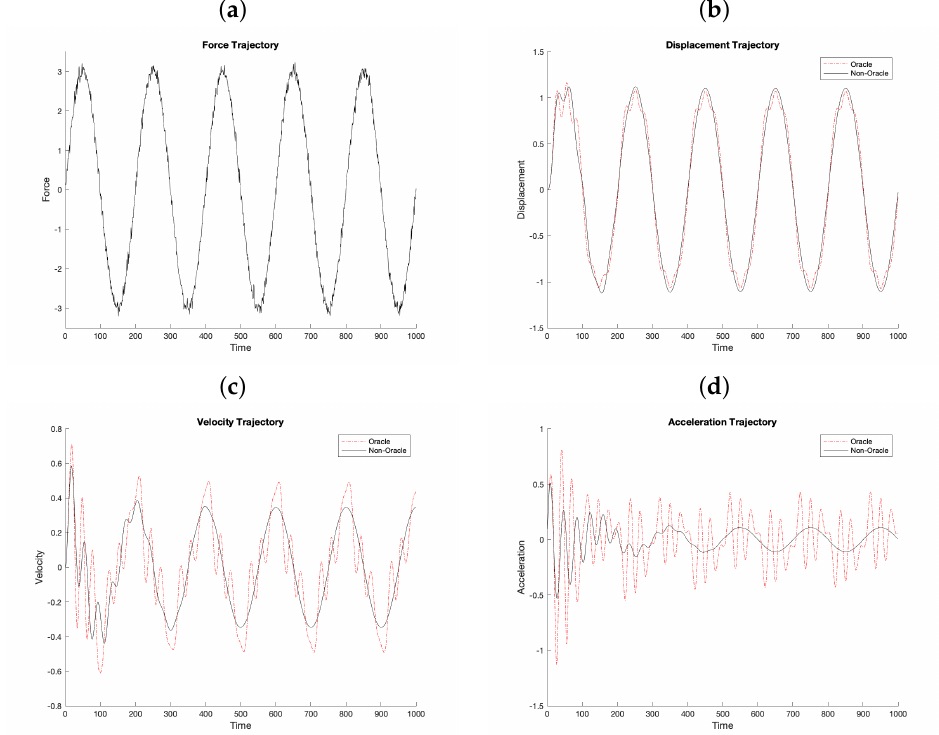
Figure 3. Force ( a ) Displacement ( b ), Velocity ( c ), and Acceleration ( d ) trajectories for Oracle and non-Oracle models with σ (cid:101) =